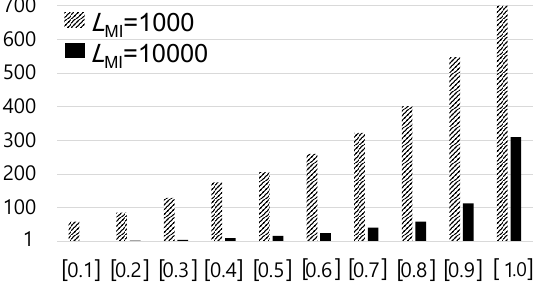
Figure 3. Average number of feasible choices of each task period, over varying use with L MI = 1000 and 10,000 under